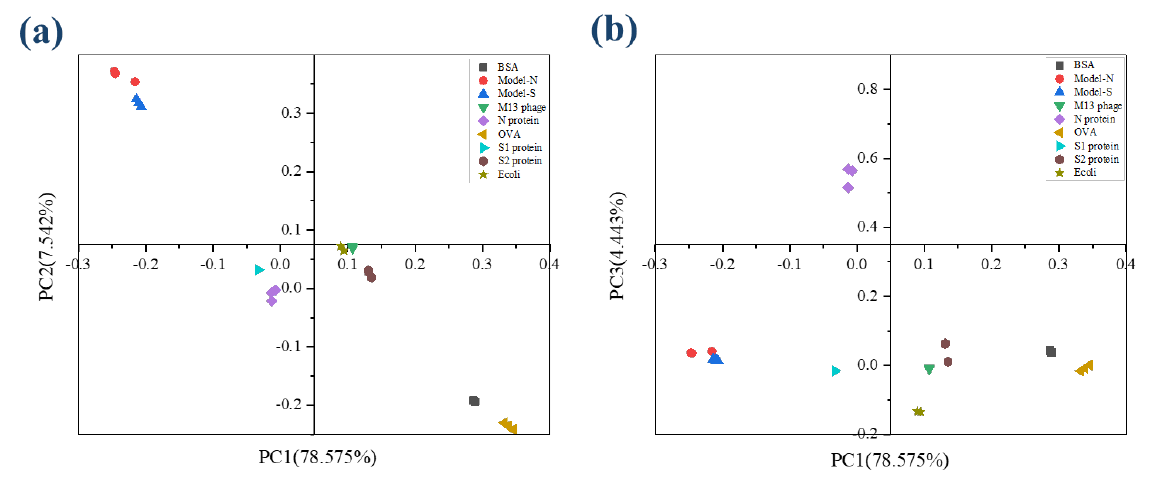
Figure 4. The scatter plot describes the scores for the nine samples from RS after PCA analysis. ( a ) Coordination PC1 − PC2; ( b ) Coordination PC1 − PC3.